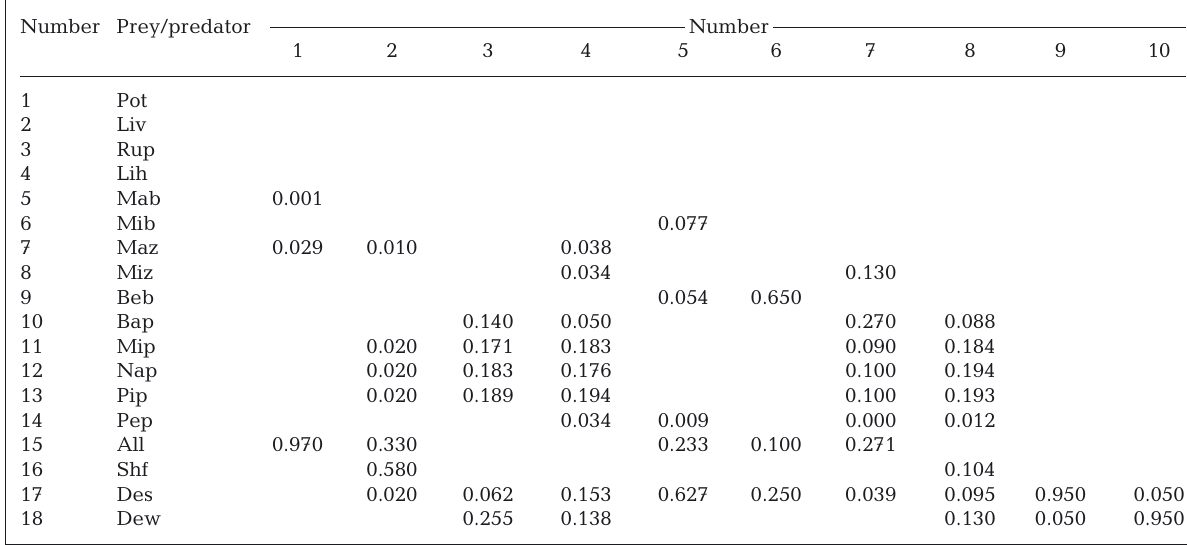
Table 1. Diet composition of the consumers in a 4-species polyculture ecosystem model. The proportion of each prey group in the predator’s diet is indicated by the displayed values (blanks = zero). Pot: Portunus trituberculatus ; Liv: Litopenaeus